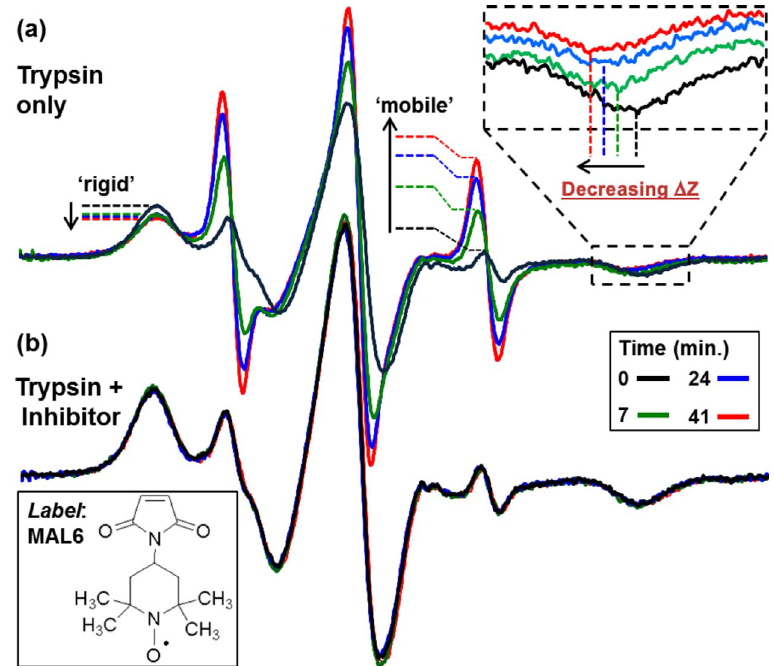
Figure 2. (a) ESR SL spectra of MAL6-labeled BSA (0 min, black) as well as 7, 24, and 41 min after addition of trypsin (green, blue, and red curves). Note the changes in the spectral features: the increase in the intensity of the three main peaks (mobile population), the decrease in the intensity of the leftmost peak (rigid population) and the shift in the position of some of the peaks on the right (reduction in D Z , see inset) indicating a decrease in molecular weight of the rigid population. (b) ESR SL spectra for the same experiment as part (a), but now in the presence of a trypsin